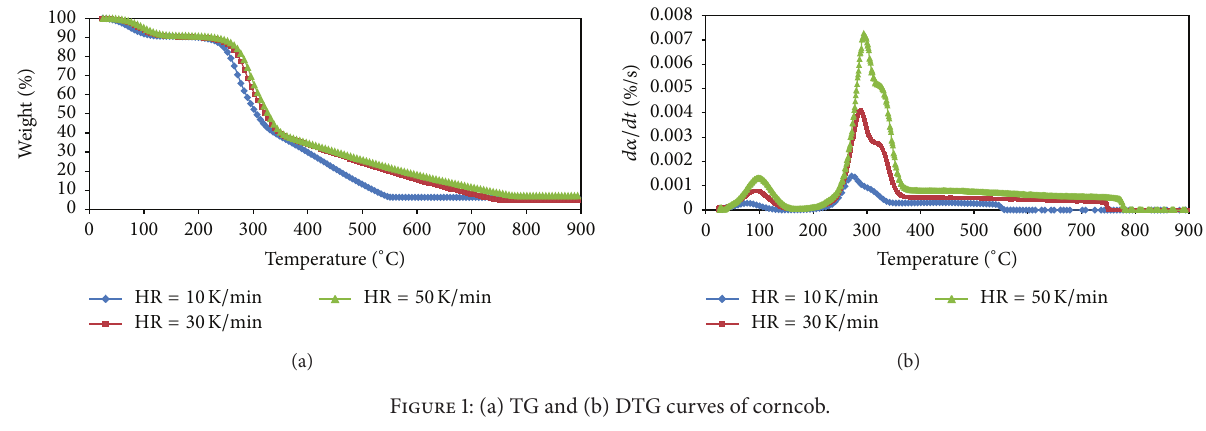
Figure 1: (a) TG and (b) DTG curves of corncob.